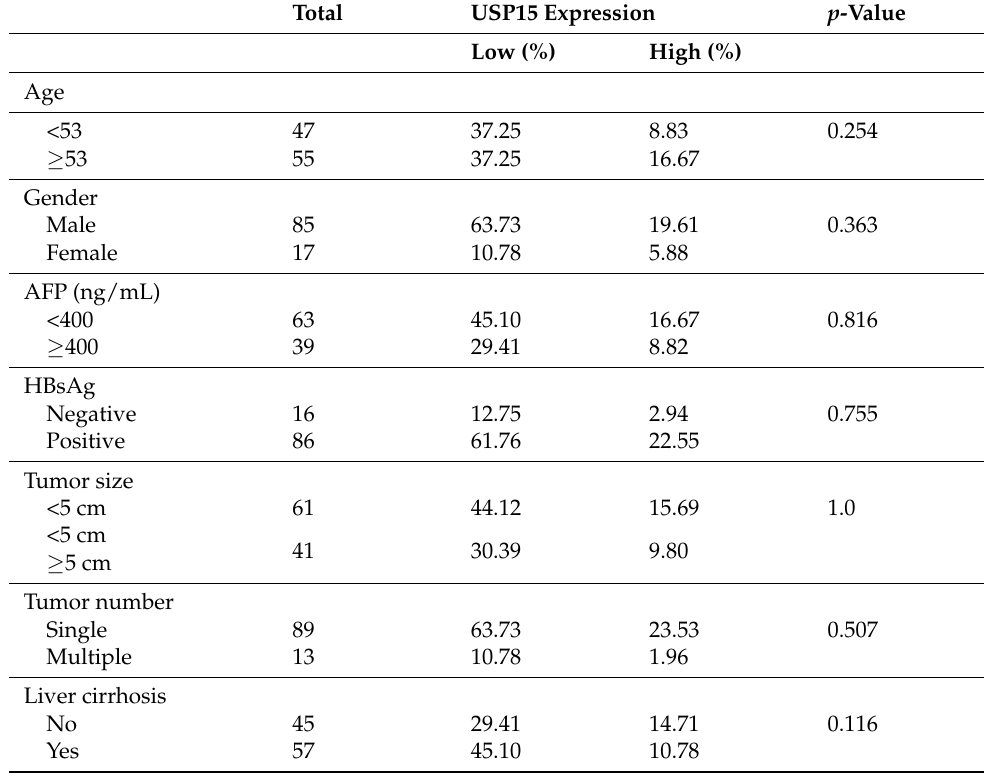
Table 1. Clinical and pathological characteristics of the patient cohort of 102 patients suffering from HCC. A tissue sample of each patient was immunohistochemically stained (IHC) for USP15. By visual inspection, two pathologists classified the stained tissue into low or high expression, see text. All p -values (two-tail Fisher’s exact test [22]) are above 0.05, and hence, no significance differences of USP15 expression exist in the patient subgroups of clinical characteristics, e.g., age (young/old)